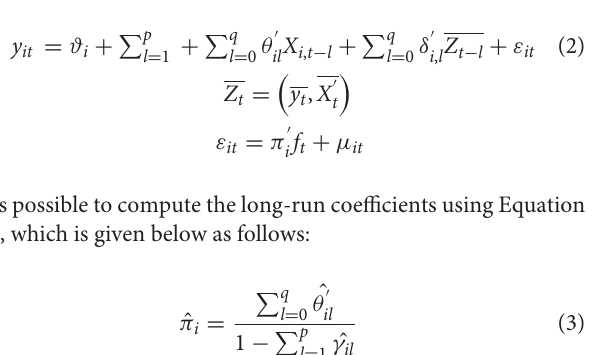
unobserved common factor, which causes dependency among cross-sectional units, is denoted by f t . Detrended cross-sectional averages deal with the common factors, and their lags are represented by the Equation (3). The pooled mean group (PMG) approach will estimate the coefficients in Equation